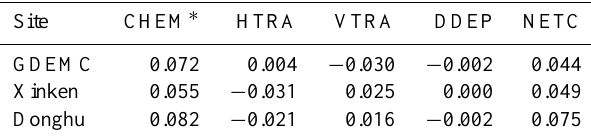
Table 5. Summary of the average accumulated contributions of each process to O 3 formation over the depth of layers 1 to 7 for the period of 09:00 to 15:00LST during 16–22 October 2004 at the GDEMC, Xinken, and Donghu sites (ppm/6h).